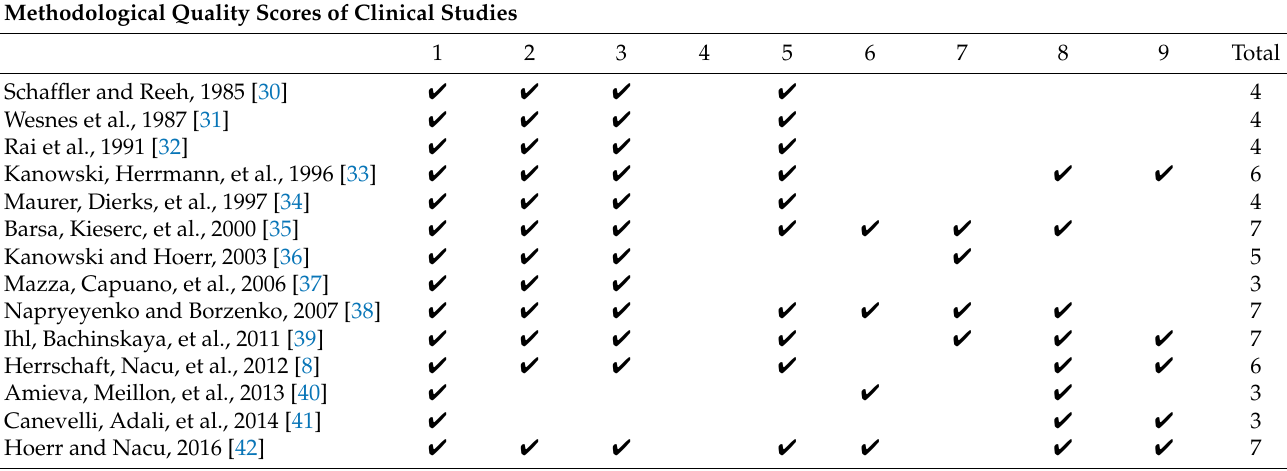
Table 6. Methodological quality scores of GBE-related clinical